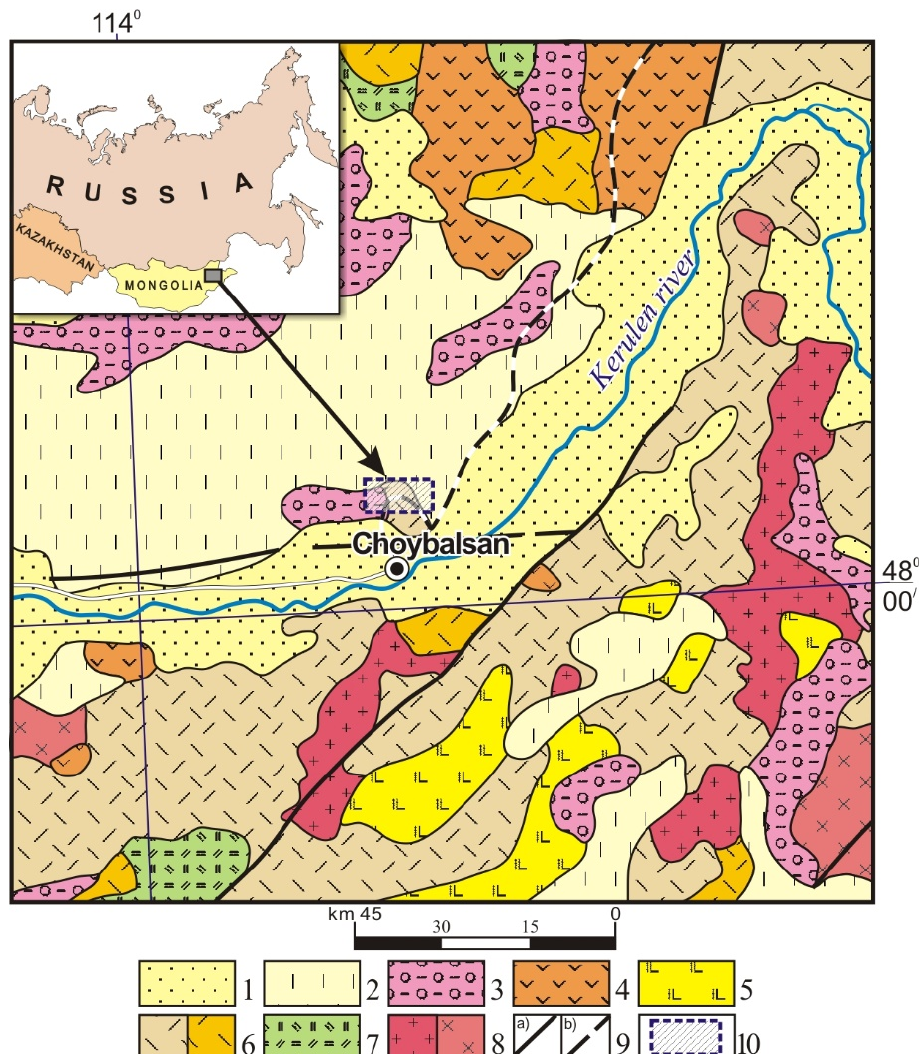
Figure 6. The location and geological map of the study area [65]. Note: 1—Quaternary gray-colored sandy rubble deposits; 2—Paleogene–Neogene gray-colored terrigenous (clayey siltstone, occasionally clayey sand) deposits; 3—Lower Cretaceous coal-bearing molasse; 4—Upper Jurassic– Lower Cretaceous basalt, basaltic andesite, and andesite; 5—Upper Jurassic–Lower Cretaceous basalt– trachybasalt, trachyandesite; 6—Middle–Upper Permian rhyodacite, rhyolite; 7—Upper Permian rhyolite, trachyrhyolite; 8—Triassic–Lower Jurassic granite, leucogranite; 9—Tectonic dislocations: (a) found, (b) assumed; 10—The developed area with the coal